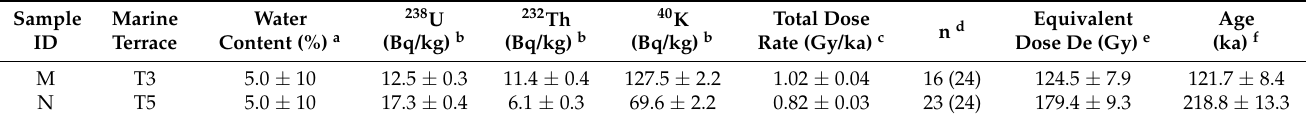
Table 1. Radionuclide concentrations, dose rates, equivalent doses, and OSL ages for collected samples.